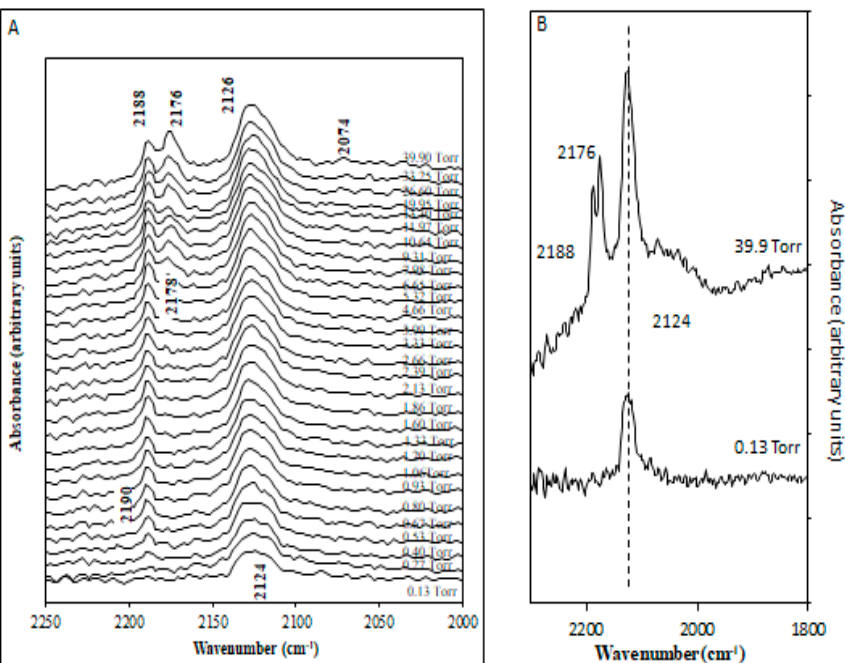
Figure 5. ( A ) FT-IR spectra of CO adsorbed on Rh/CeO 2 at 90 K. Indicated pressure are those of CO (upon exposure at the indicated pressure for 1 min each), the working pressure is ~10 − 4 Torr. ( B ) Spectra obtained at the first (0.13 Torr) and at the last (39.9 torr) CO exposure.